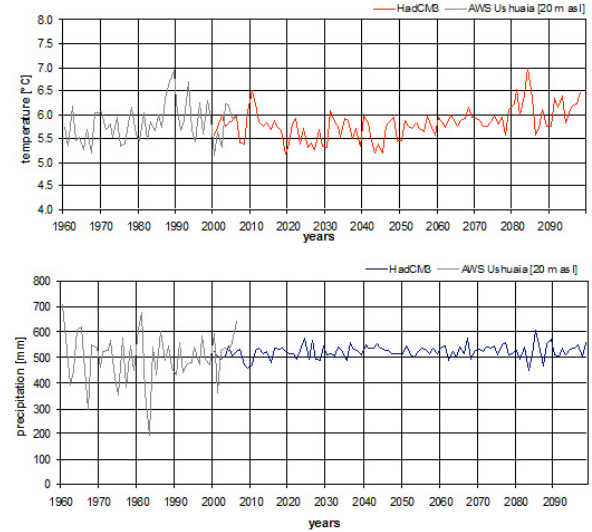
Fig. 7: Fig. 6. Measured and downscaled climate data time series for the period 1960–2099. Error estimation regarding the downscaling of the HadCM3